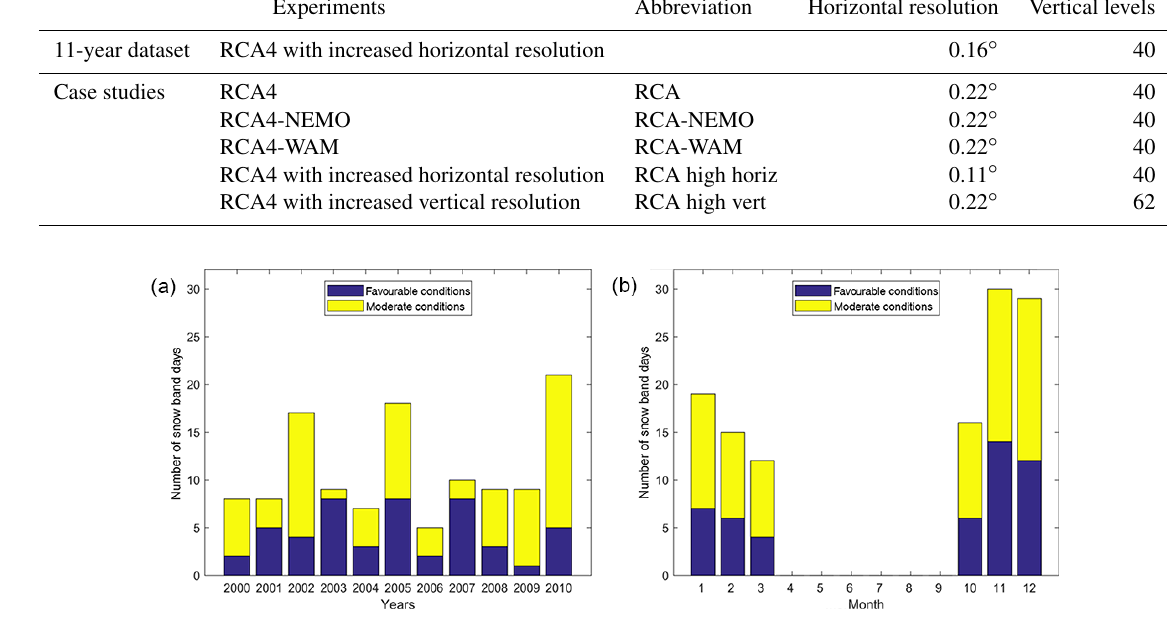
Figure 3. Number of snow band days fulfilling the applied criteria per year (a) and month (b) .